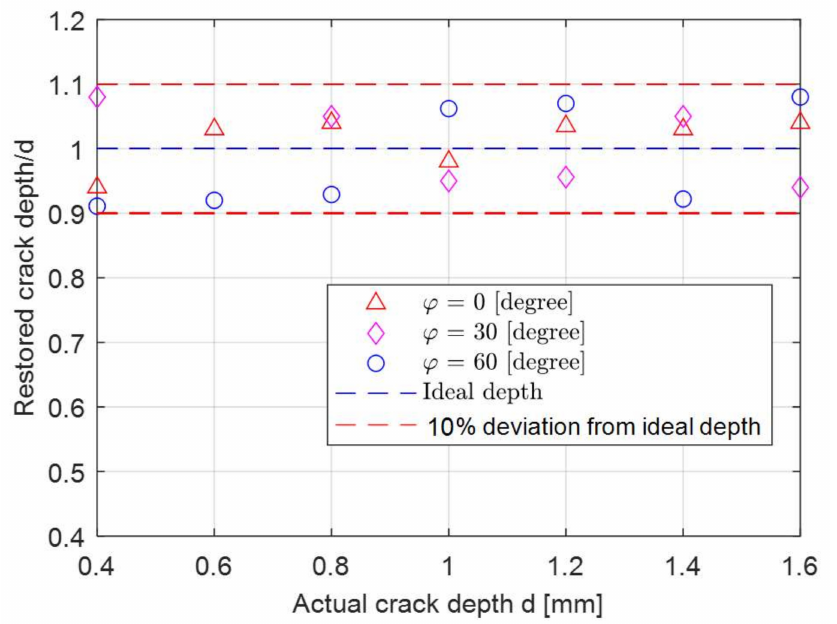
Figure 15. Retrieval of the surface crack slot versus actual depths for the tilt angles of 0, 30, and 60